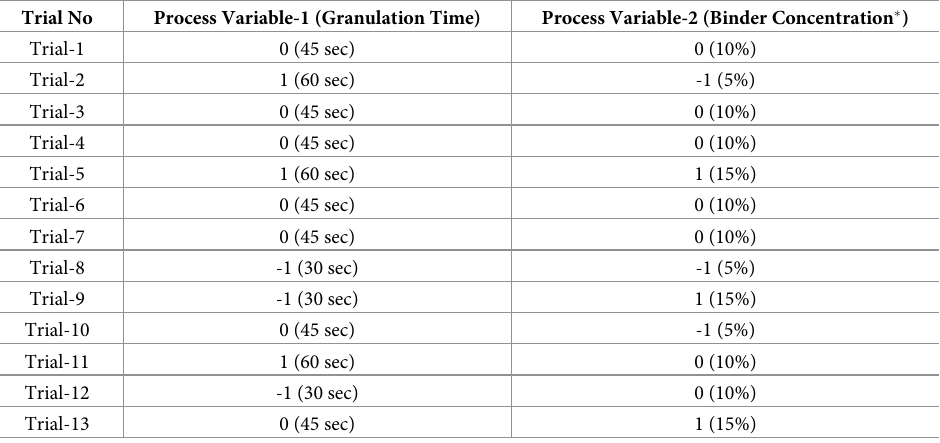
Table 2. Different combinations of process variables for preparation of granules by high shear wet granulation. Trial No